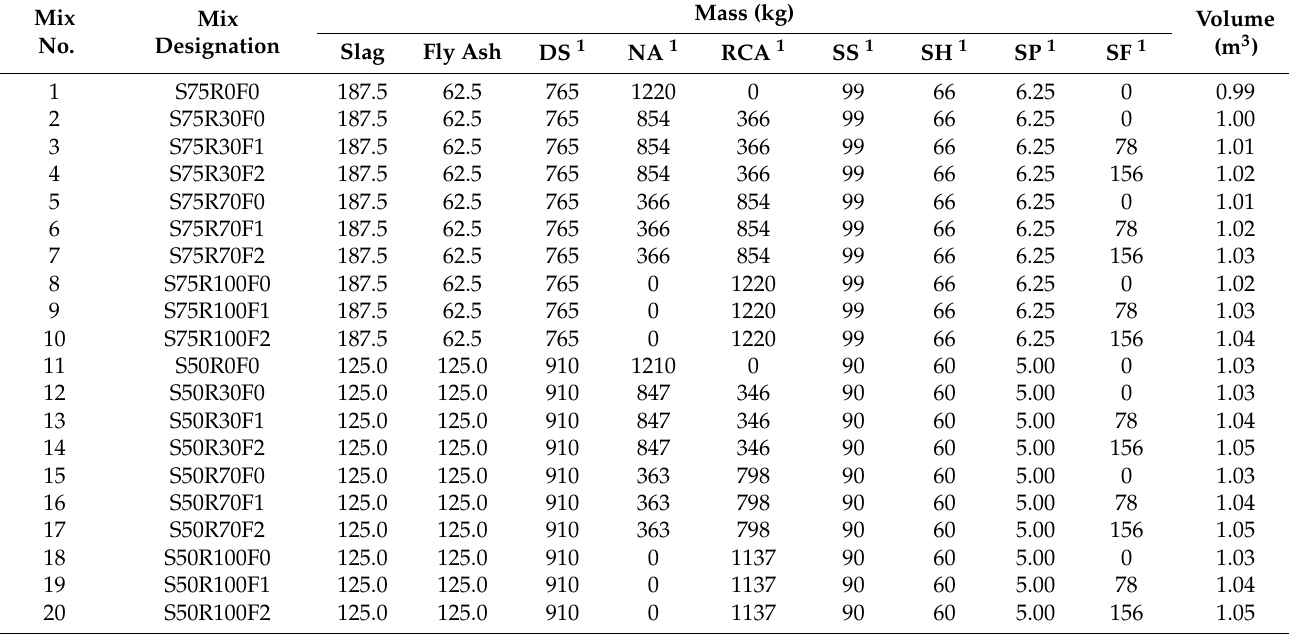
Table 4. Mix proportions of alkali-activated slag concrete